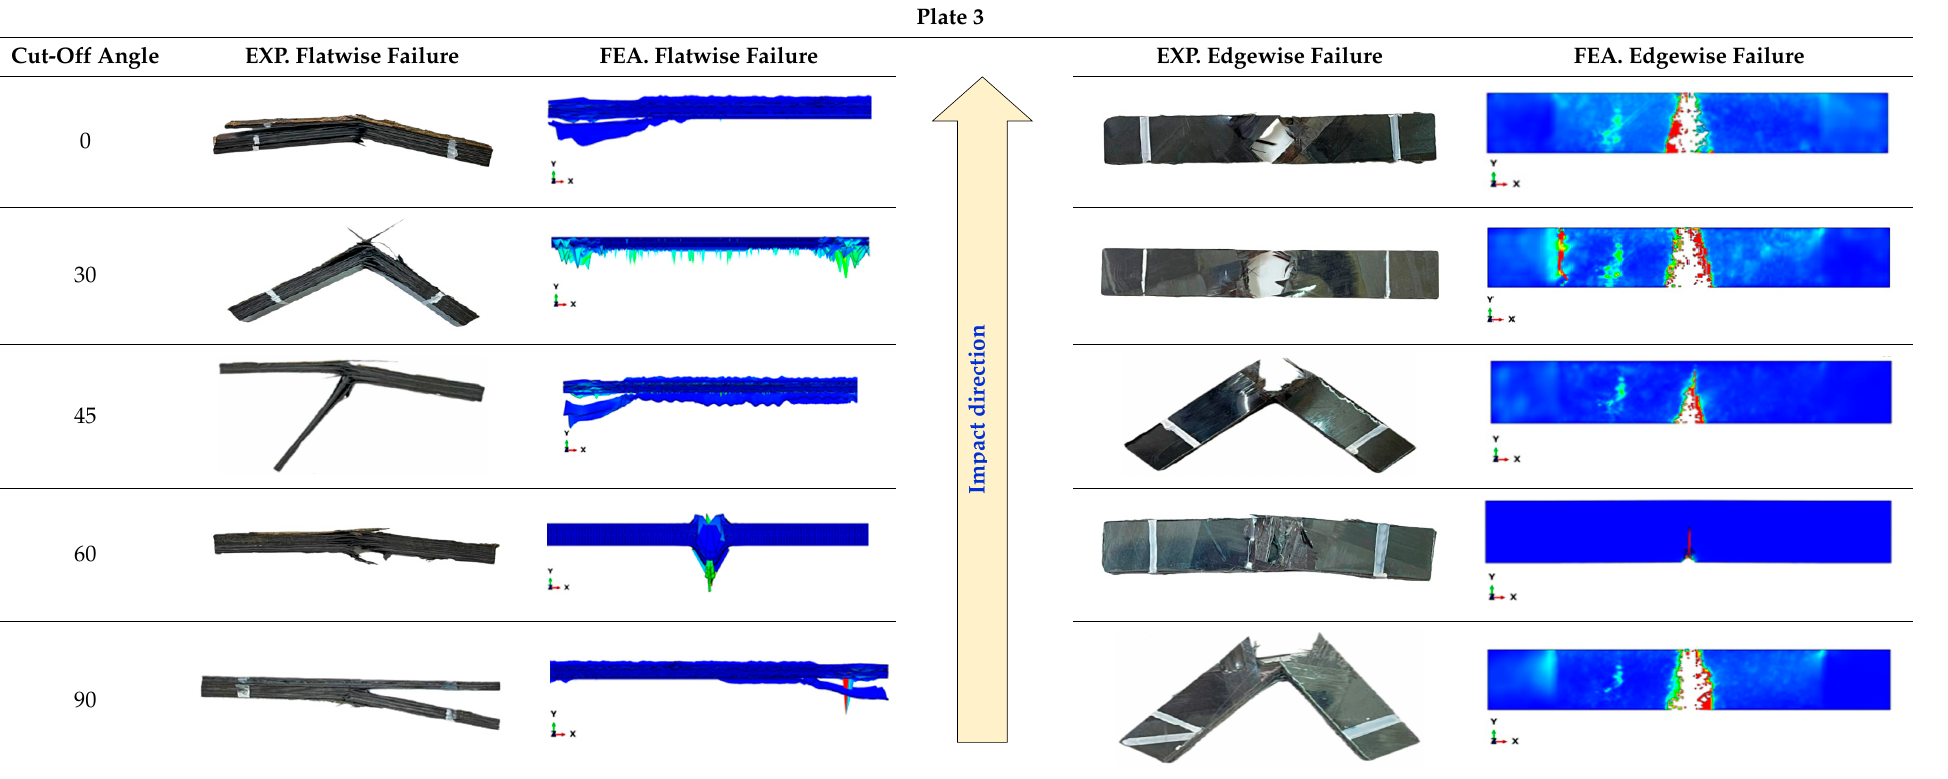
Table 5. Failure modes of Plate 3 under Charpy impact test conditions.